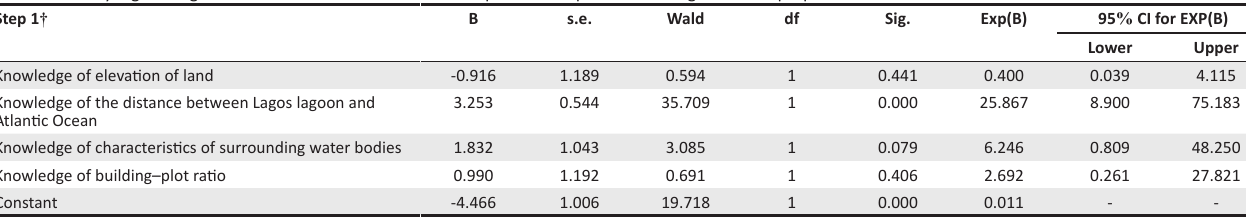
TABLE 5: Binary logistic regression for effect of variables in the equation for spatial knowledge on flood preparedness.